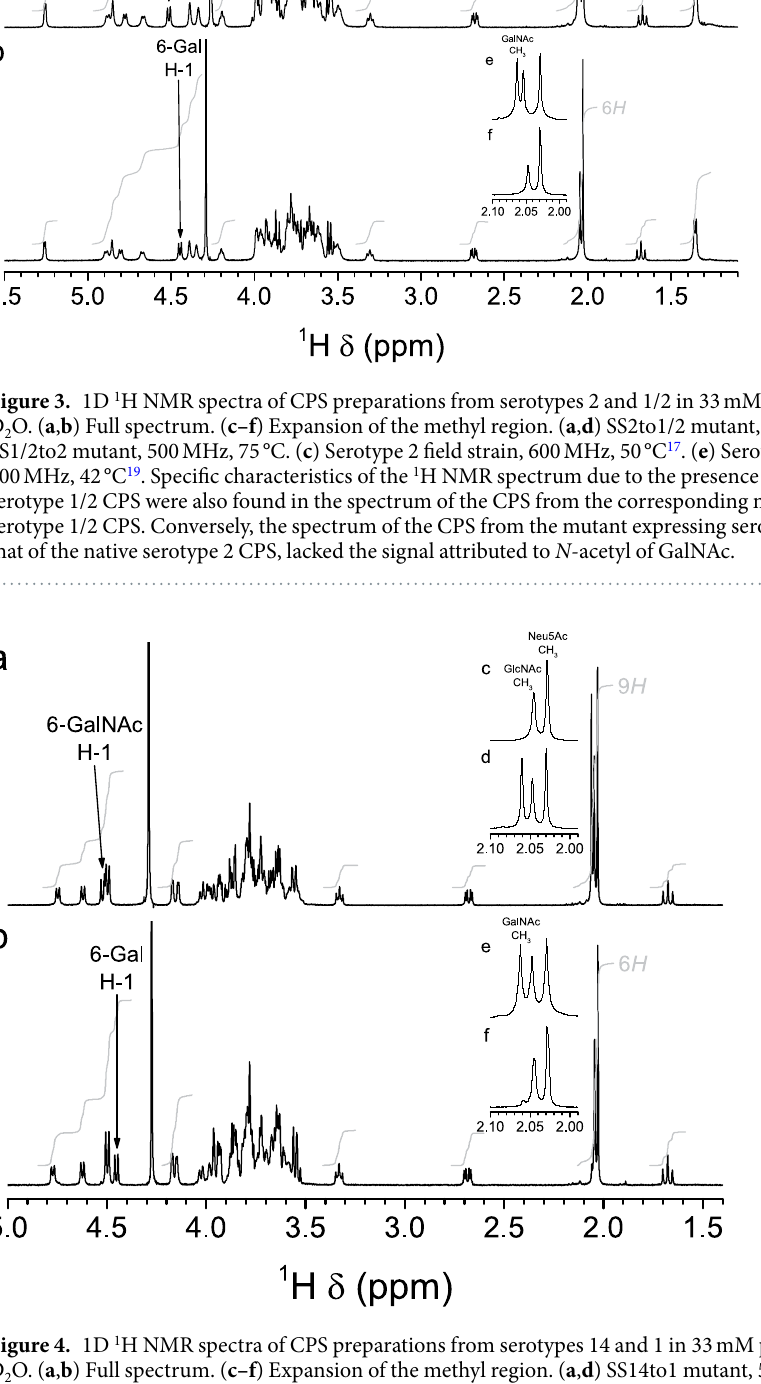
5 Scientific RepoRts | 7: 4066 | DOI:10.1038/s41598-017-04403-3